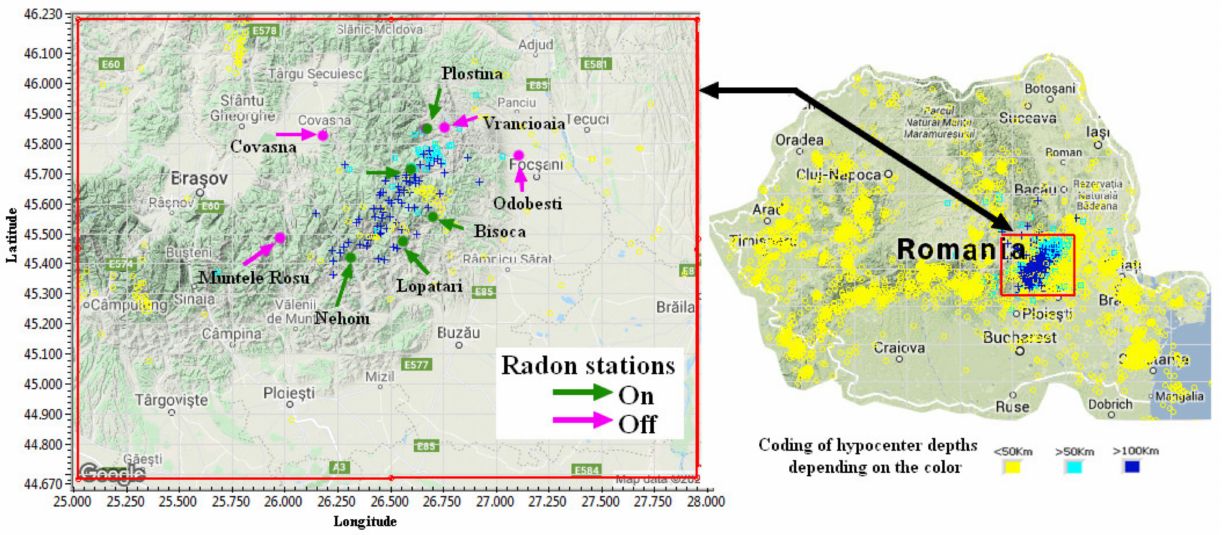
Figure 1. Romania and Vrancea seismicity, radon monitoring